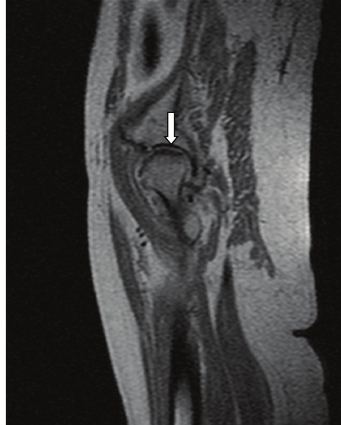
Figure 1: Aseptic necrosis (avascular) of the left femoral head with flattening of the subchondral bone (arrow).